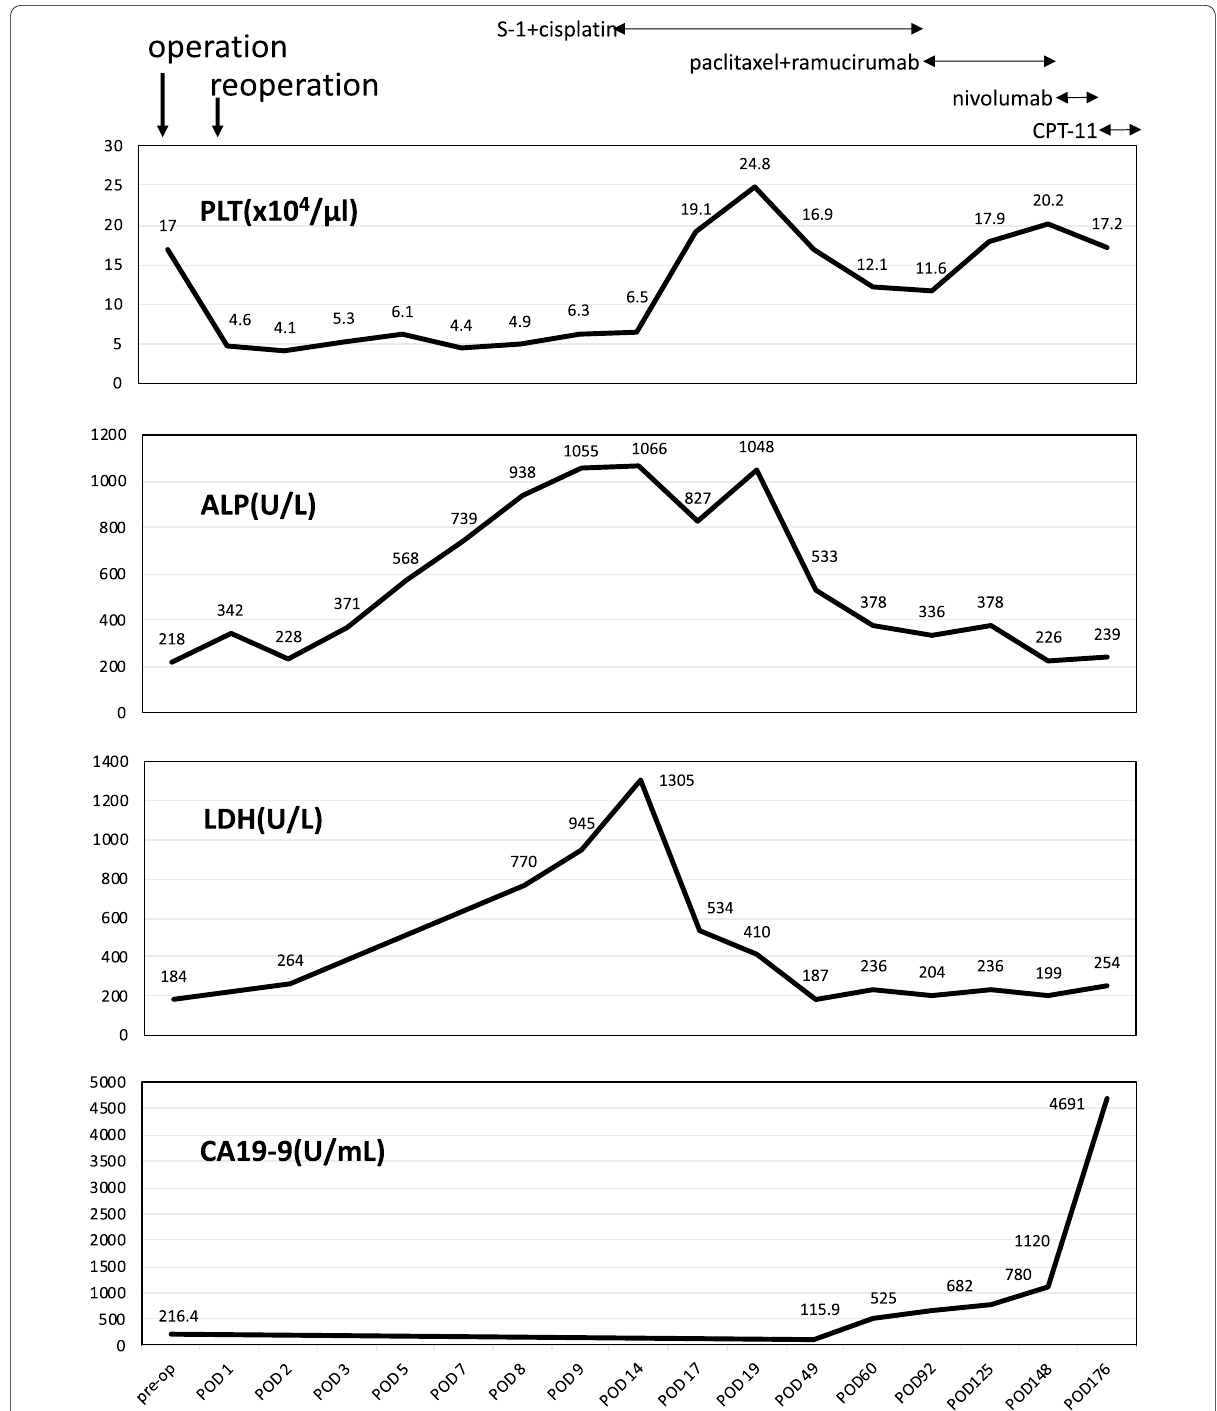
Fig. 2 Clinical course of the patient including the surgery, chemotherapy, and clinical